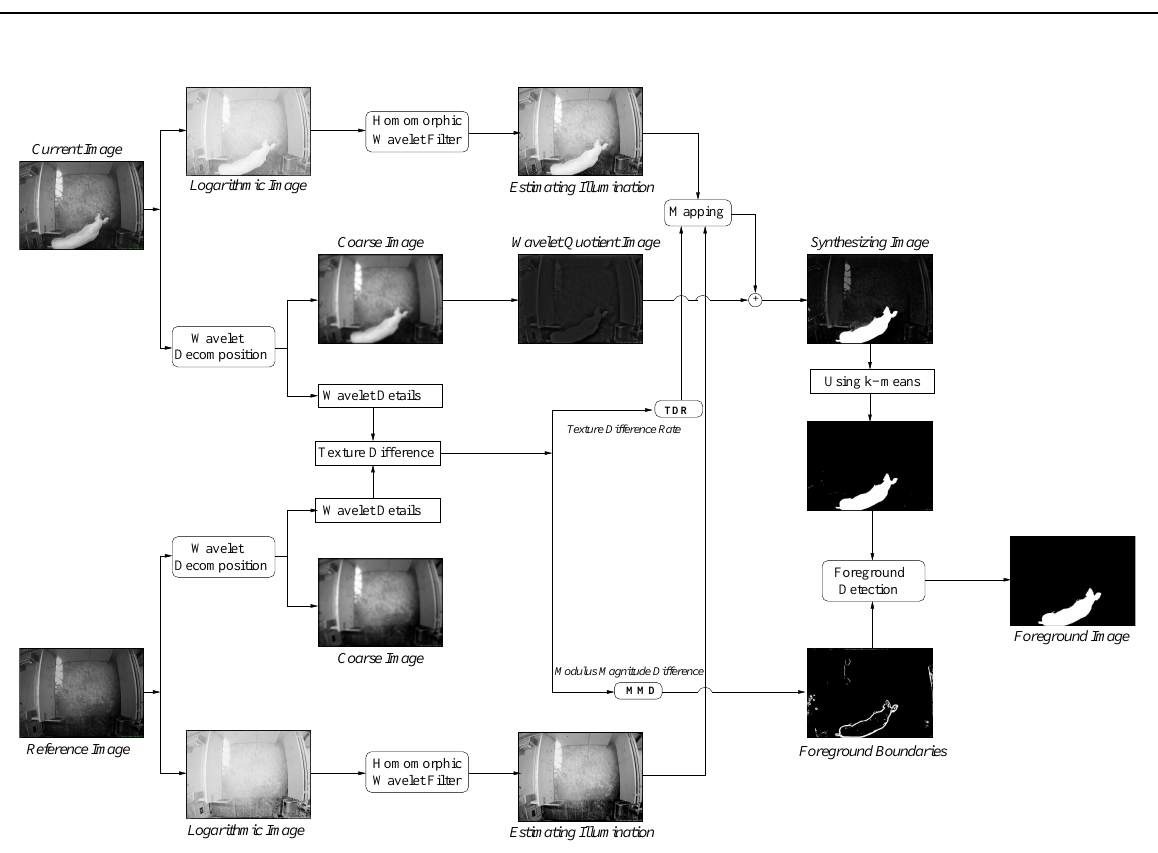
Figure 2. The flowchart of our algorithm. Three images are used to synthesize: two estimating illumination images and a wavelet quotient image ( i.e ., the reflectance component of the current